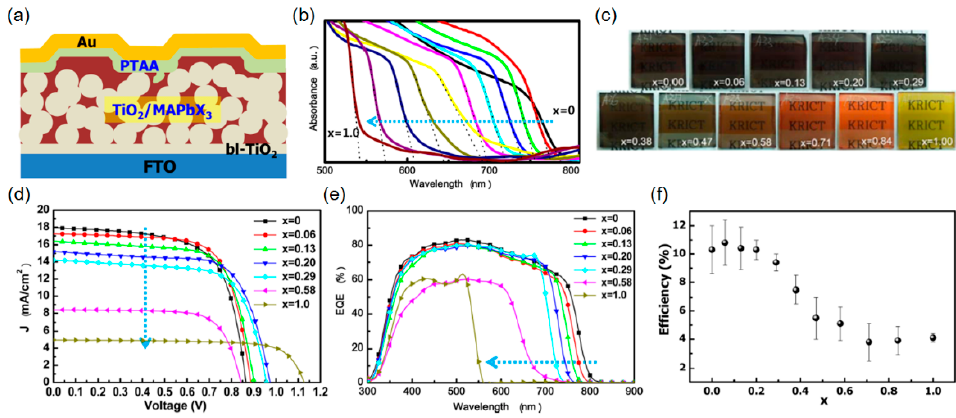
Figure 8. ( a ) Device configuration of the hybrid heterojunction solar cell consisting of the 3D TiO 2 / Methyl Ammonium (MA)PbX 3 bilayer nanocomposites, polytriarylamine (PTAA) layer, and Au layer on the blocking TiO 2 layer (bl-TiO 2 ) coated FTO substrate. ( b ) UV − vis absorption spectra of FTO/bl-TiO 2 /mp-TiO 2 /MAPb(I 1 − x Br x ) 3 /Au cells measured using an integral sphere. ( c ) Photographs of 3D TiO 2 /MAPb(I 1 − x Br x ) 3 bilayer nanocomposites on FTO glass substrates. ( d ) J − V characteristics of